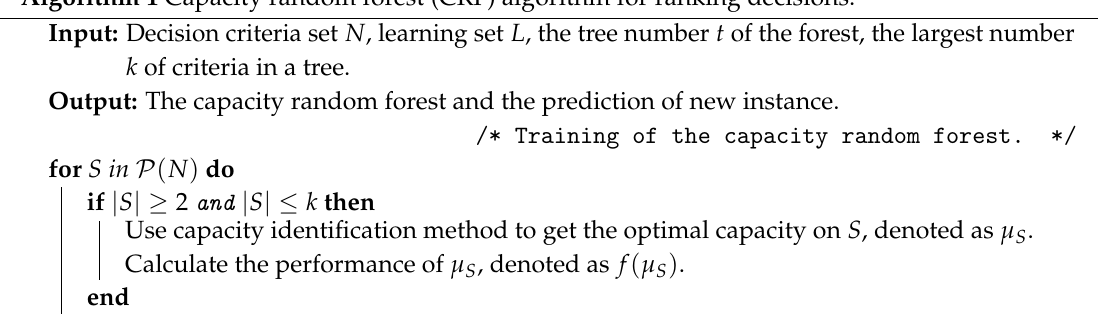
Algorithm 1 Capacity random forest (CRF) algorithm for ranking